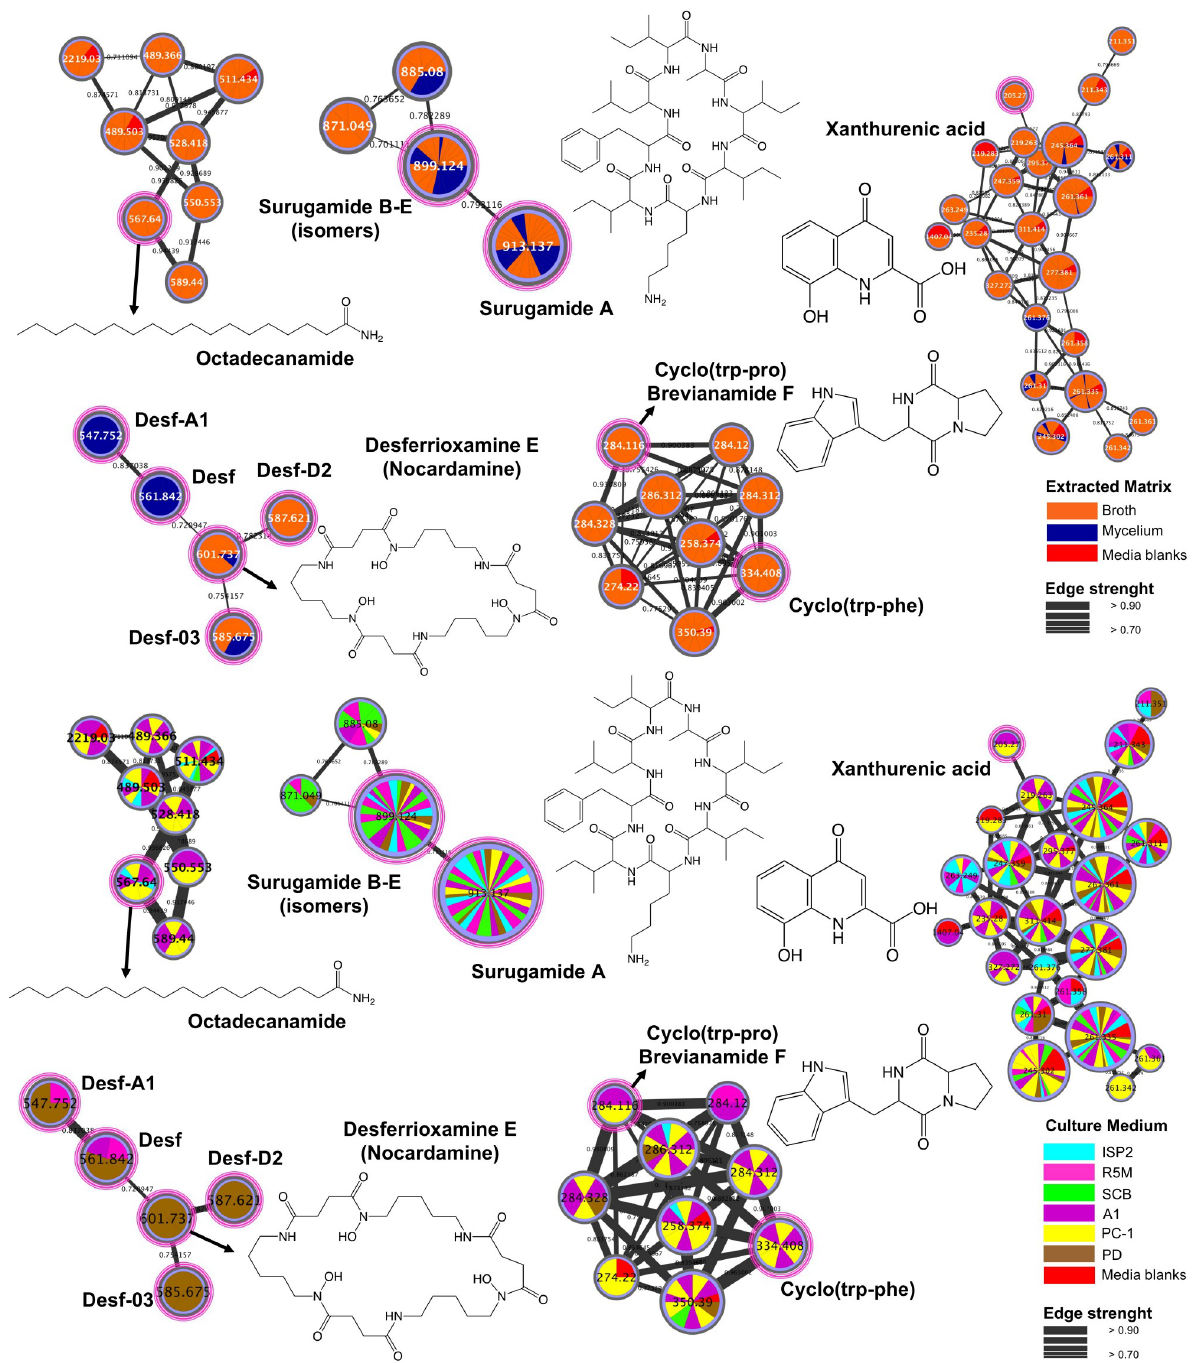
Fig 1. Molecular network constructed with LC-MS/MS data obtained from the crude extracts produced by Streptomyces sp. BRB081 in six different media during seven days of cultivation. Clusters of molecular families are depicted twice and show the detected compounds in broth and mycelium when both parts are separately extracted and across different media. Nodes corresponding to the spectral library match are colored in pink. The structures shown are related to annotated compounds.